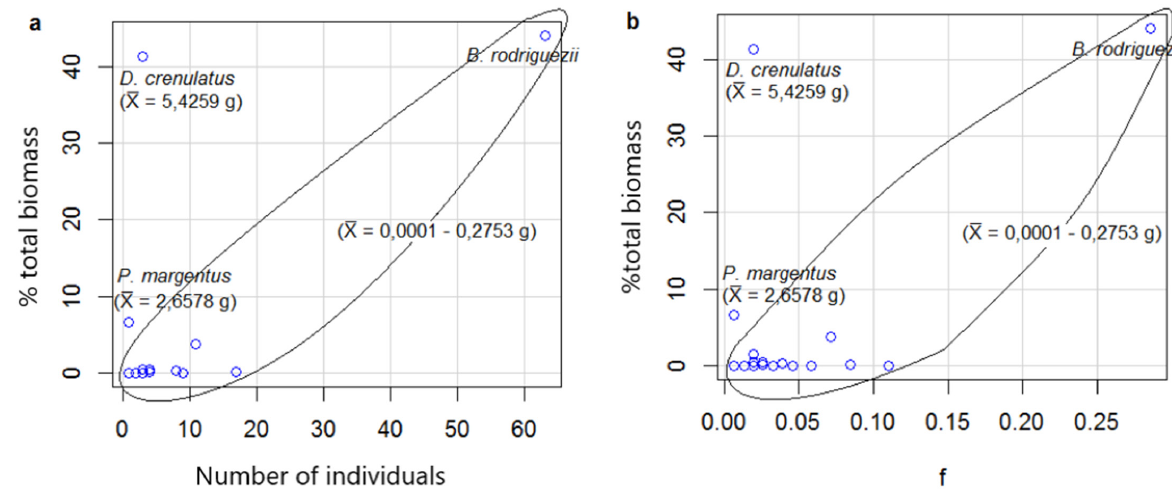
Figure 1. a. Percentage of total biomass ingested by Bunodosoma zamponii in relation to the number of captured individuals from each prey item. Only the items in which the number of individuals could be quantified were taken into account. In parentheses is indicated the average biomass of each prey (X - ). b. Percentage of total biomass ingested in relation to the frequency index of prey (f) of each consumed item. In parentheses is indicated the average biomass of each prey (X -